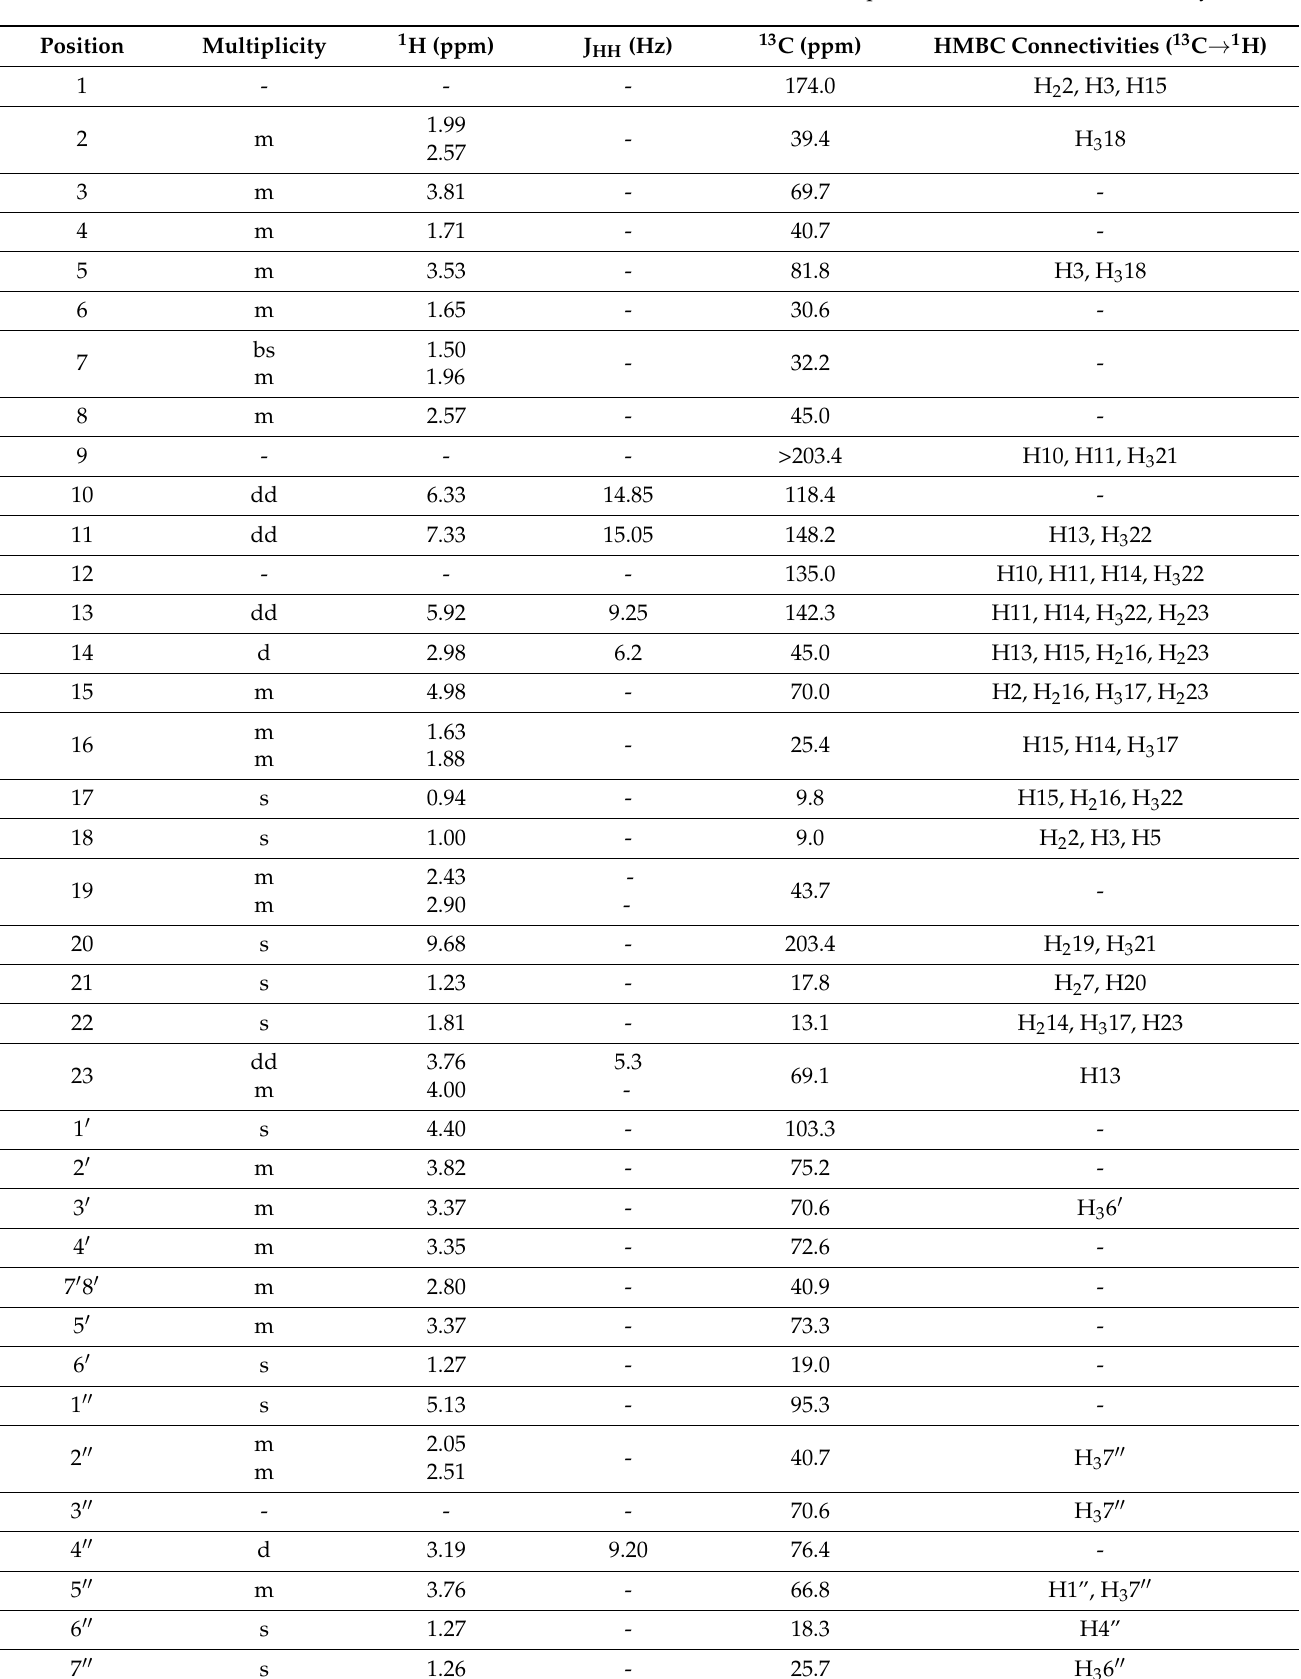
Table 1. The chemical shifts, coupling constants, and HMBC connectivities for tylosin A in CDCl 3